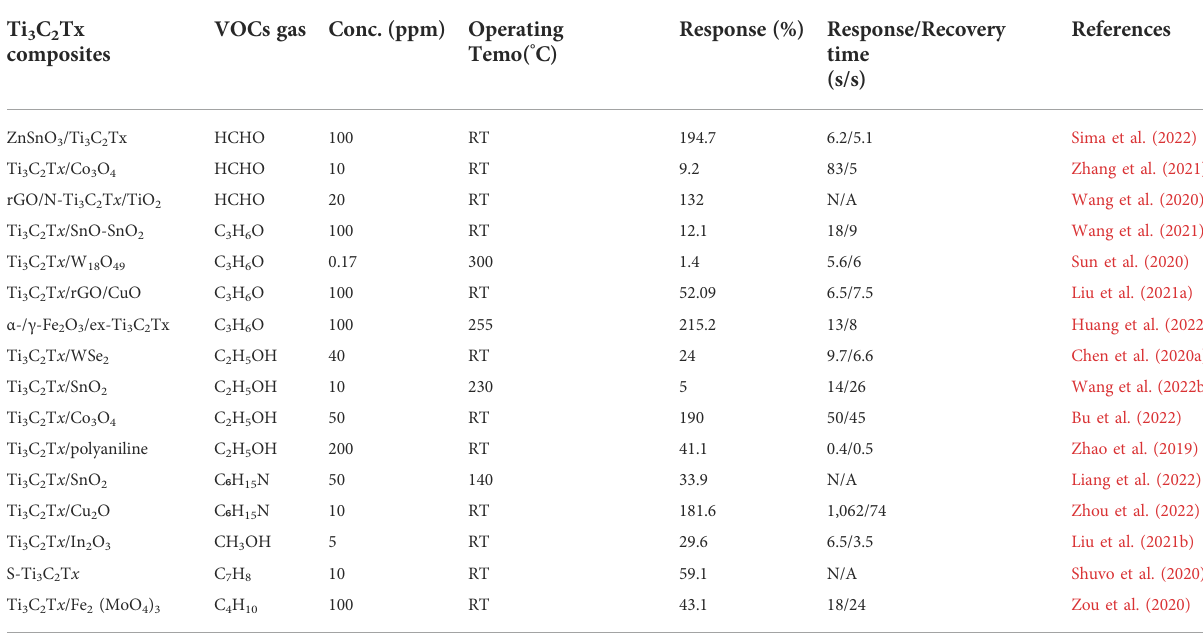
TABLE 2 Gas sensing performances of Ti3C2Tx-based gas